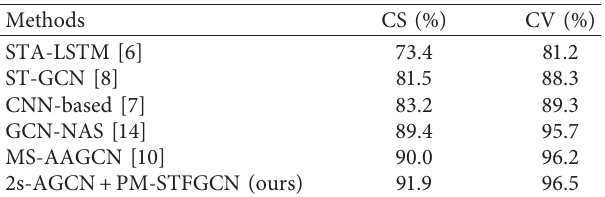
Table 3: Comparison of CS and CV benchmarks with state-of-the- art schemes.